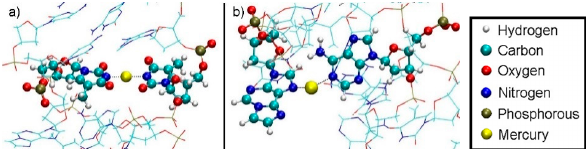
Figure 16. Final geometry of structure 2 at D DNA = 10.4 Å with no water displayed. ( a ) Hg2 is bound between T 19-N3 from the base pair originally adjacent the modified base and T 7-N3 from the modified base pair. T 19 transferred its N3–H proton to A 6-N1 during the equilibration MD due to the presence of Hg(II). ( b ) Final geometry of structure 2 after thermodynamic integration at D DNA = 10.4 Å with water not displayed. Hg1 is bound by A 8-N1 from the base pair originally below the modified base and ε A